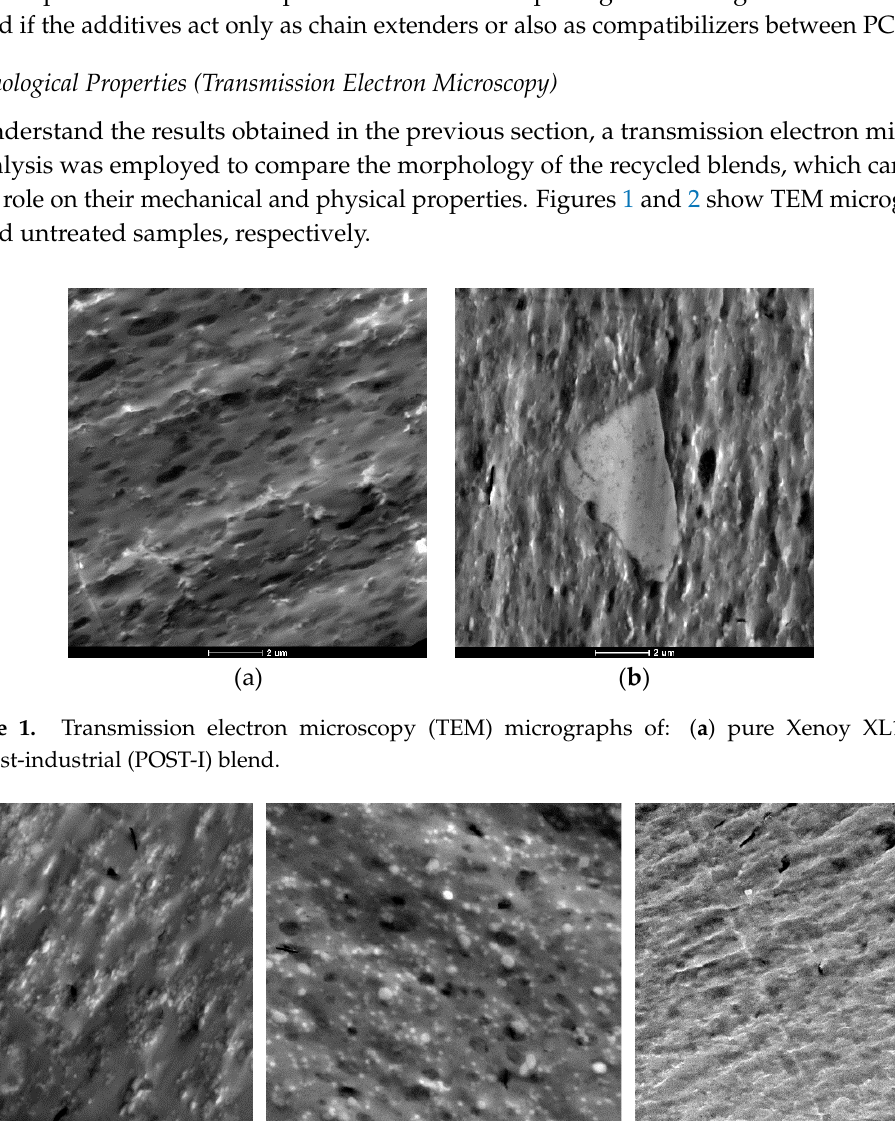
Figure 2. TEM micrographs of: ( a ) POST-I + 5% epoxy styrene-acrylic oligomer (ESAo); ( b ) POST-I + 5% methylene diphenyl diisocyanate (MDI); ( c ) POST-I + 5% ethylene copolymer (EMAco).